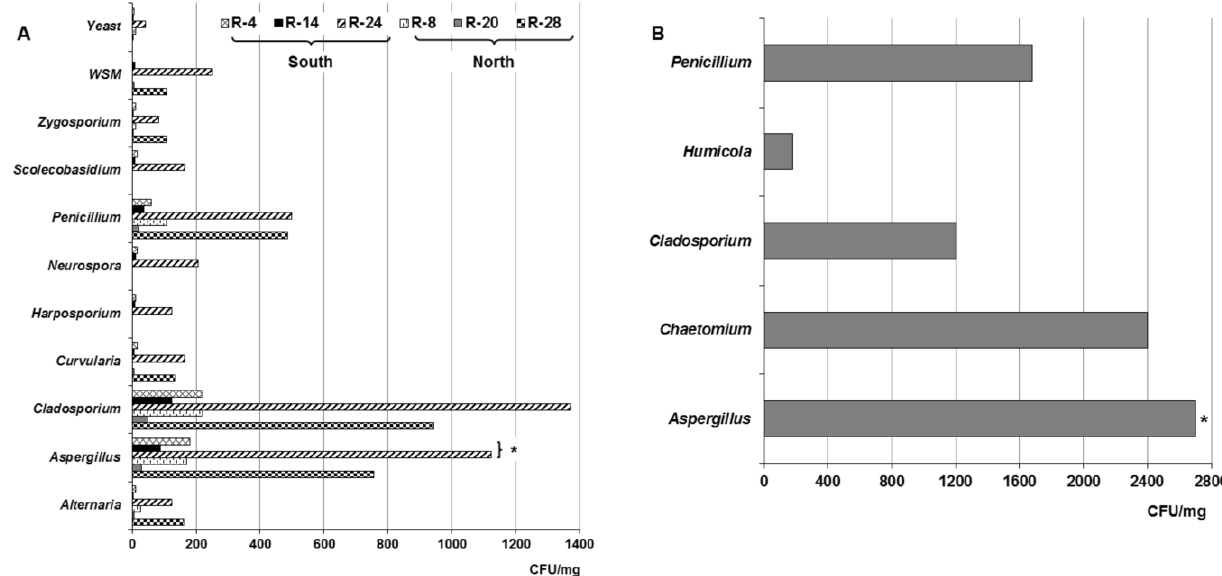
FIGURE 2: Concentrations of the fungal taxa, non-sporulating mycelium and yeast detected in the dust collected from the repositories with natural cross-ventilation system (A) and the Map library with air-conditioning (B). WNSM: White non-sporulating mycelium. *: Indi- cates different concentrations of teleomorph detected in the naturally ventilated repositories and Map library, all situated to the south part of the